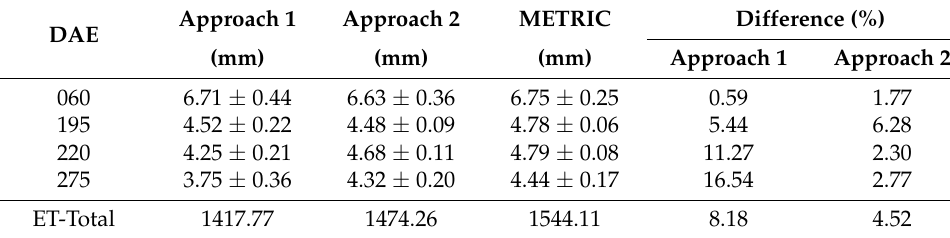
Table 5. Evapotranspiration averages for coinciding dates between Sentinel-2 and Landsat-8. Approach 1 Approach 2 METRIC Difference (%) DAE (mm) (mm) (mm) Approach 1 Approach